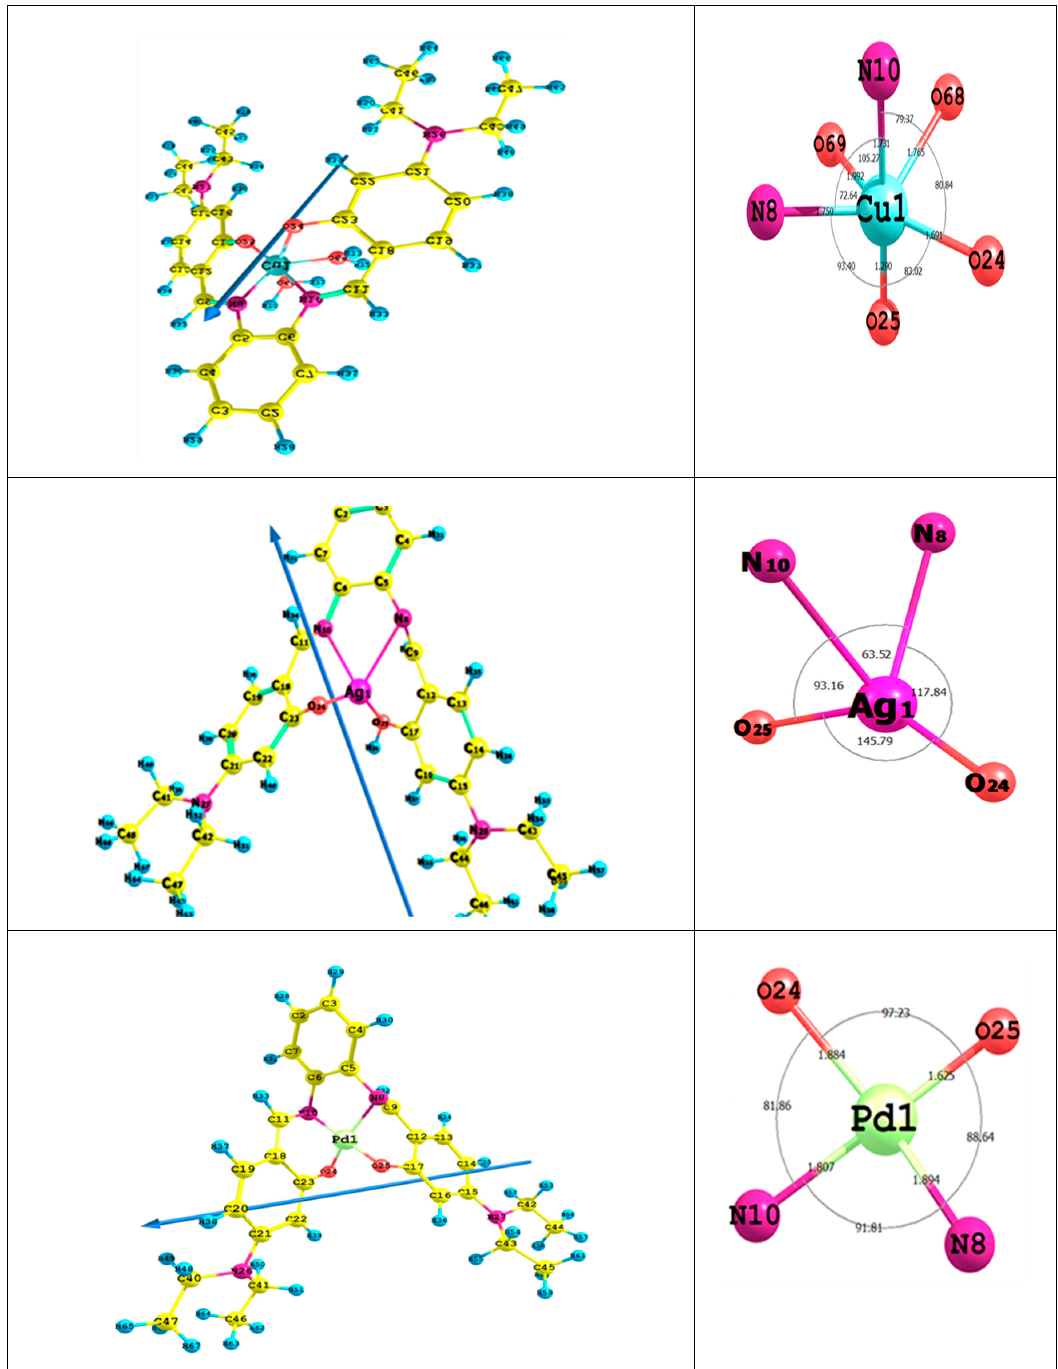
Figure 4. The bond lengths, the dipole moment vector, optimized geometry, numbering system and bond angles for the titled complexes.